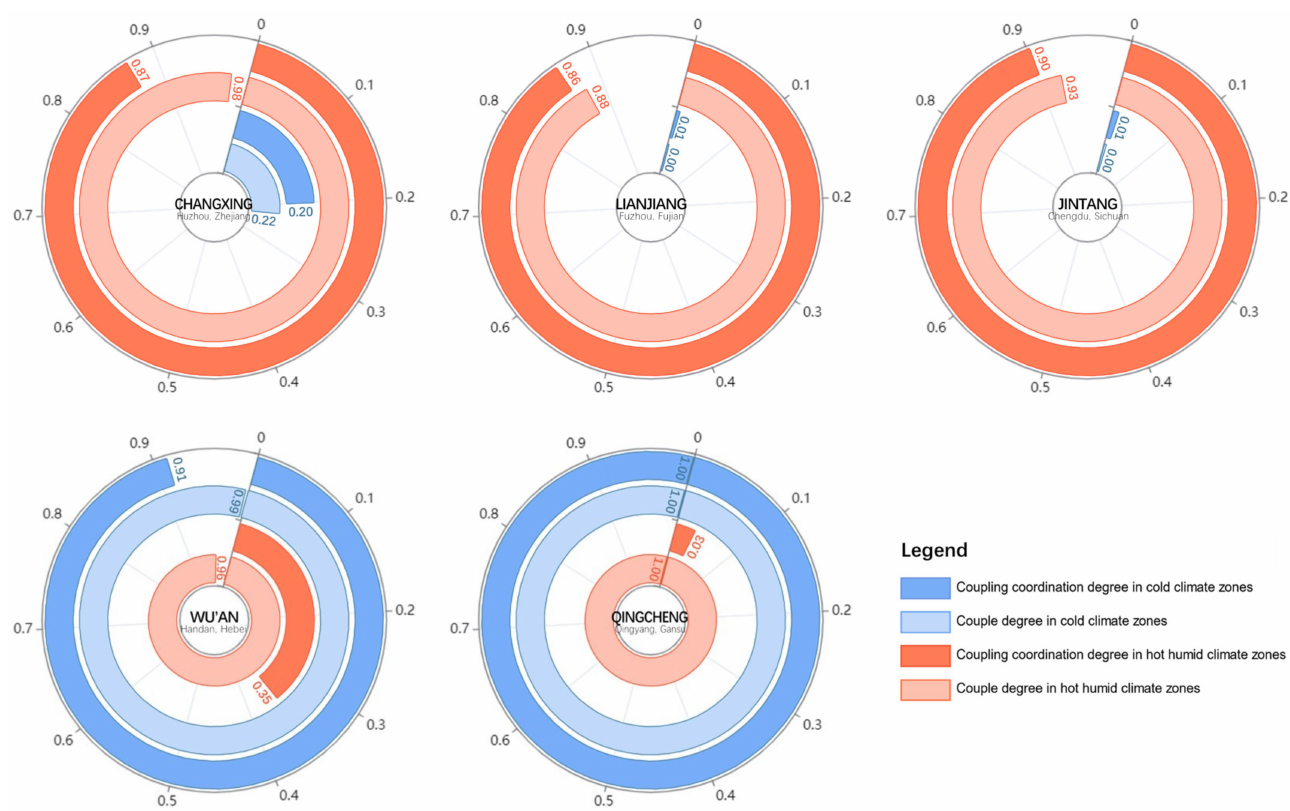
Figure 8. Evaluation results of spatial identity in central urban area of each city.